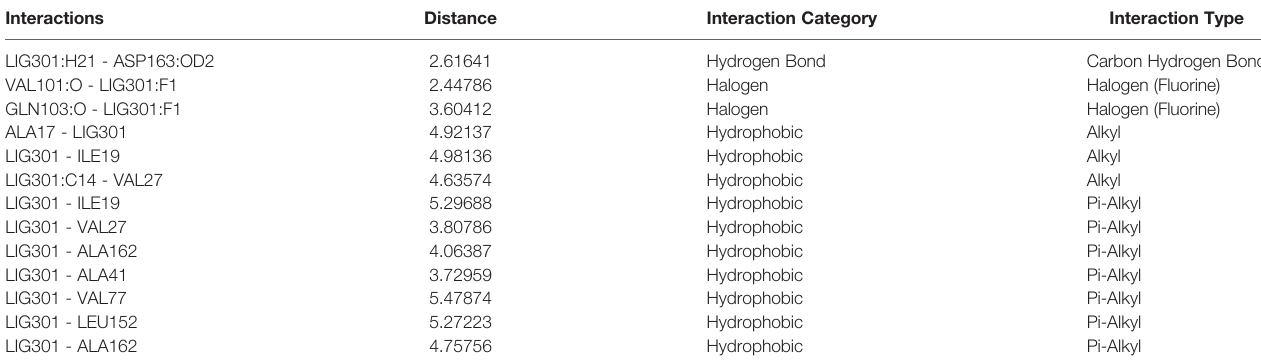
TABLE 1 | List of interactions of selonsertib against CDK6. Interactions Distance Interaction